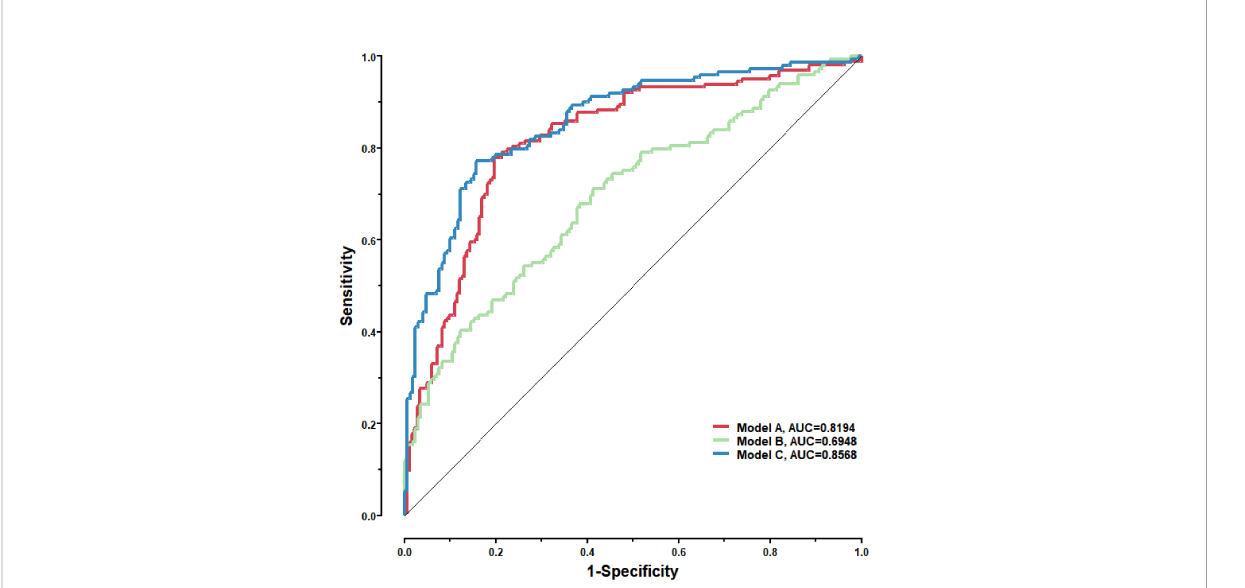
FIGURE 9 Model A: The logistic model consisting of the 8 lung cancer antigens; Model B: The logistic model consisting of 4 conventional serum tumor markers; Model C: The logistic model consisting of the 8 lung cancer antigens and the 4 conventional serum tumor